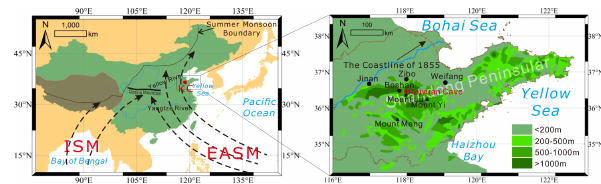
Figure 2. Location of Kaiyuan Cave and Shandong Peninsula in monsoonal China. KC: Kaiyuan Cave (36 ◦ 24 (cid:48) 32 (cid:48)(cid:48) [U + 2033]N, 118 ◦ 02 (cid:48) 05 (cid:48)(cid:48) [U + 2033]E). ISM: India summer monsoon; EASM: East Asia summer monsoon. The dashed black thin line indicates the northwestern boundary of the Asian summer monsoon. The dashed black lines with arrows indicate the routes of the summer monsoon. The dashed black lines with arrows on the left indicate the routes of the summer monsoon. The brown area is the Qinghai– Tibet Plateau. The green and brown area is China, and the yellow area is the other area.